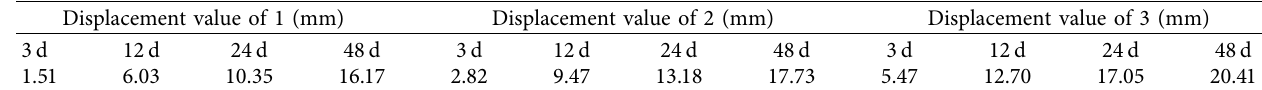
Table 5: The tunnel monitoring